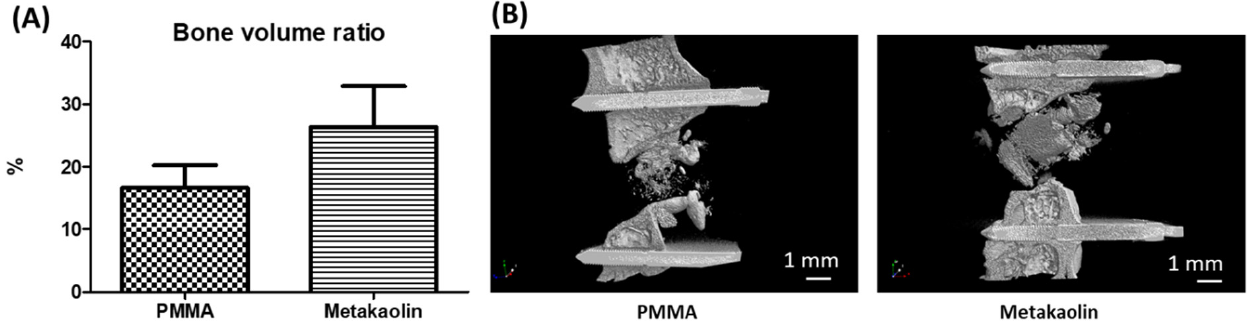
metakaolin group (16.65% ± 3.59% versus 26.37% ± 6.5%, p = 0.22, Figure 6A) than in the PMMA group.